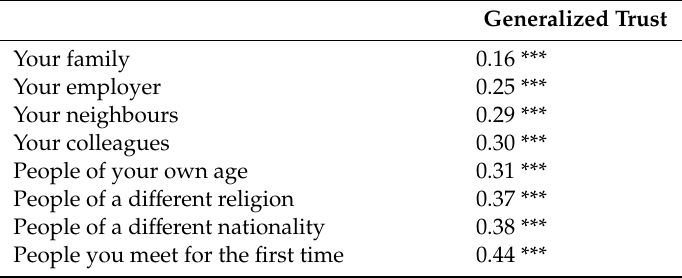
Table 3. Correlations between di ff erent forms of social